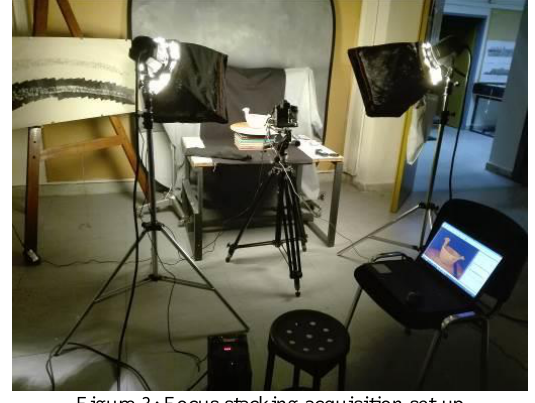
Figure 3: Focus stacking acquisition set-up